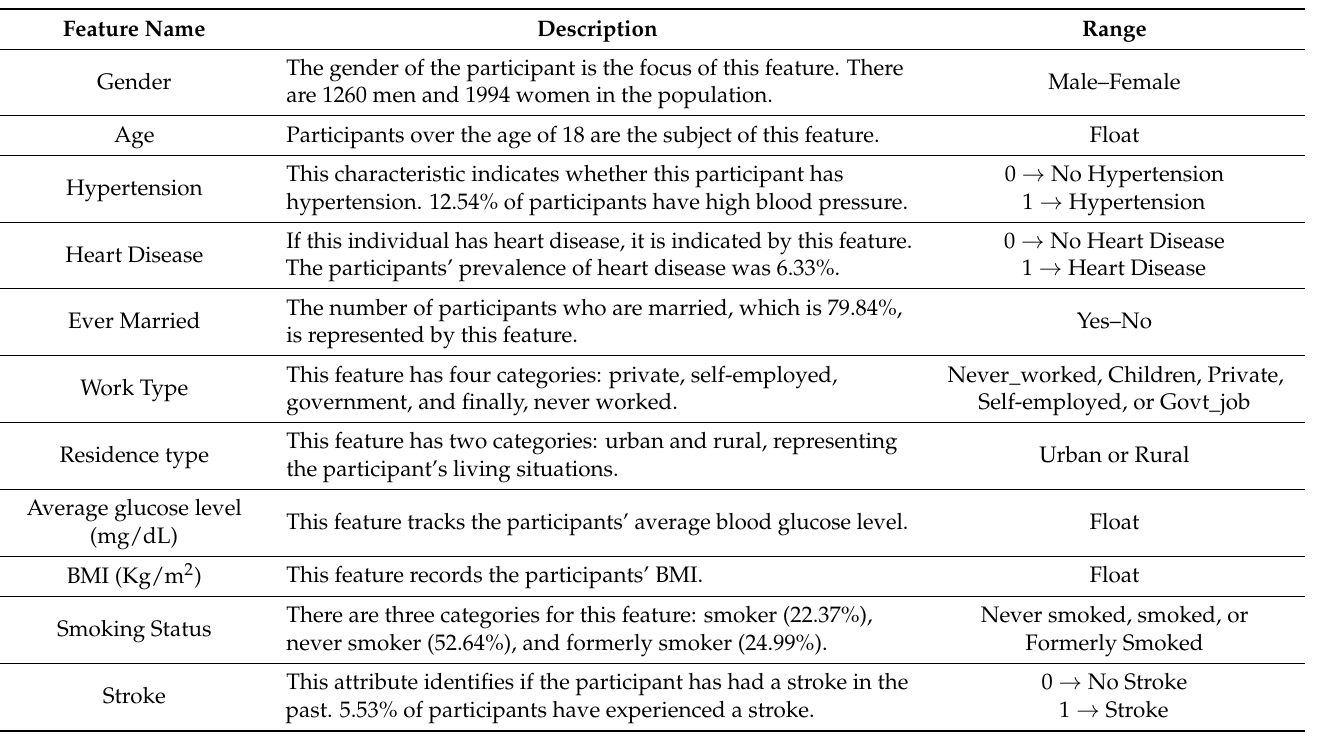
Table 1. Stroke prediction dataset